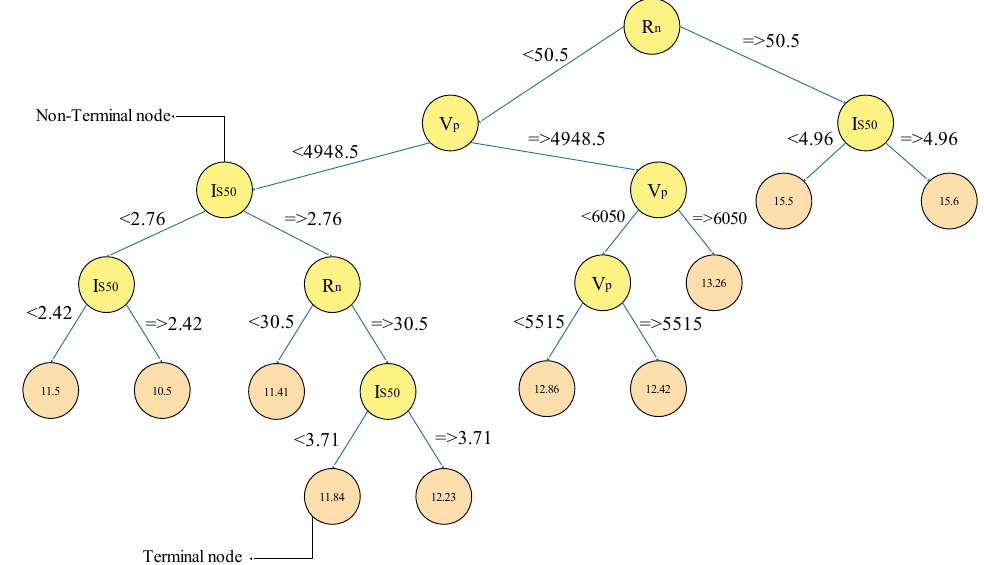
Figure 6. Decision trees of BRT model for prediction of BI. Table 4. Quantitative evaluation of AI base approaches for predicting